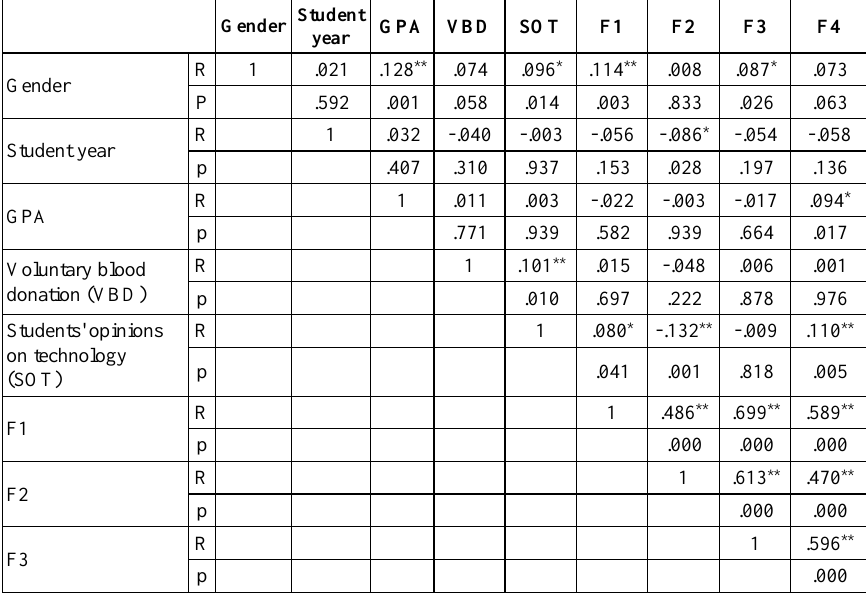
Table 4. Matrix of correlation